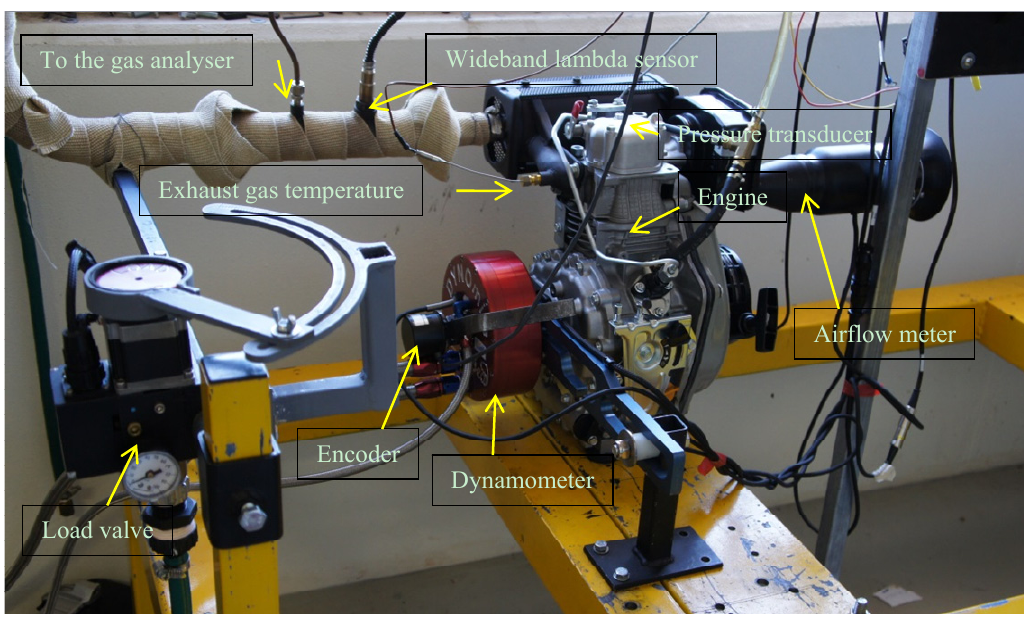
Figure 4. Engine test